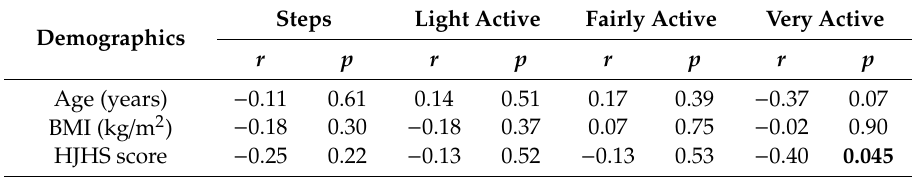
Table 3. Results of correlation